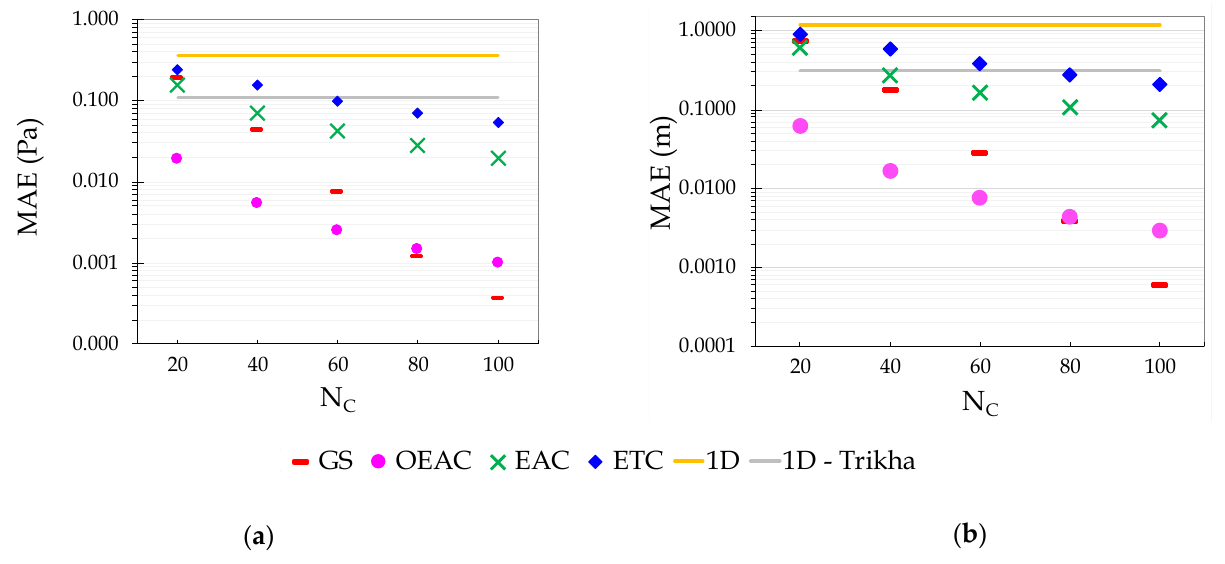
Figure 15. MAE according to Nc and radial geometry. ( a ) Wall shear stress, ( b ) piezometric head.